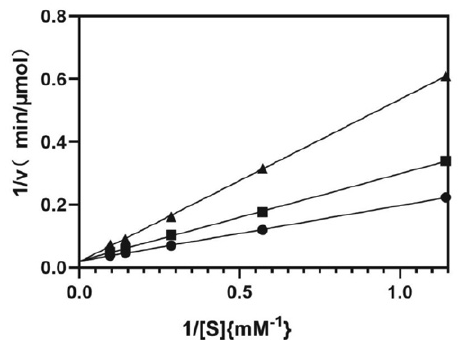
Figure 3. Double-reciprocal plot of the inhibition kinetics of β-glu- cosidase (almonds) by compound 7d . Substrate concentration: 0.875, 1.75, 3.5, 7, 10.5 mM, inhibitor concentration: 0 mM (con- trol, ▼ ), 0.1 mM ( ♦ ), 0.2 mM ( ▲ ).